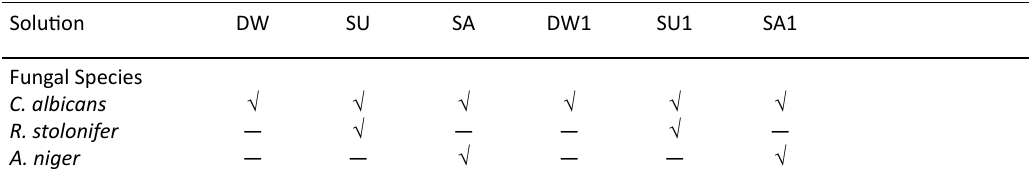
table 7. Isolation of fungal species from different solutions after dipping and removal of M. domestica immediately and one hour later Solution DW SU SA DW1 SU1 SA1 Fungal